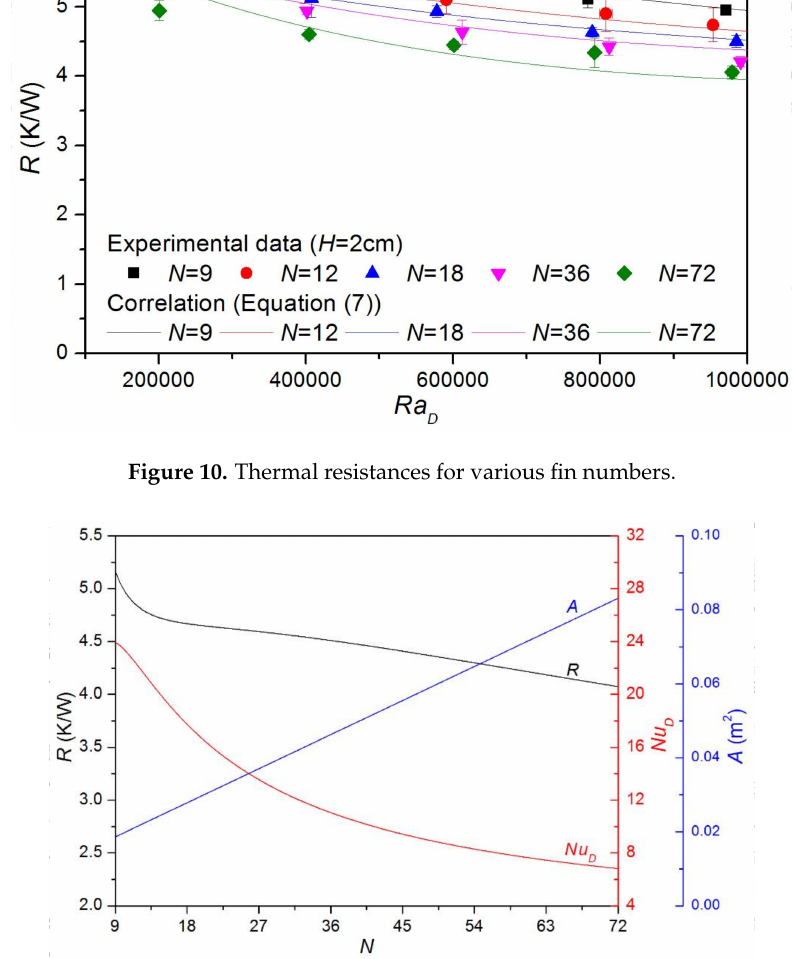
Figure 11. Effects of fin number on effective surface area, Nusselt number, and thermal